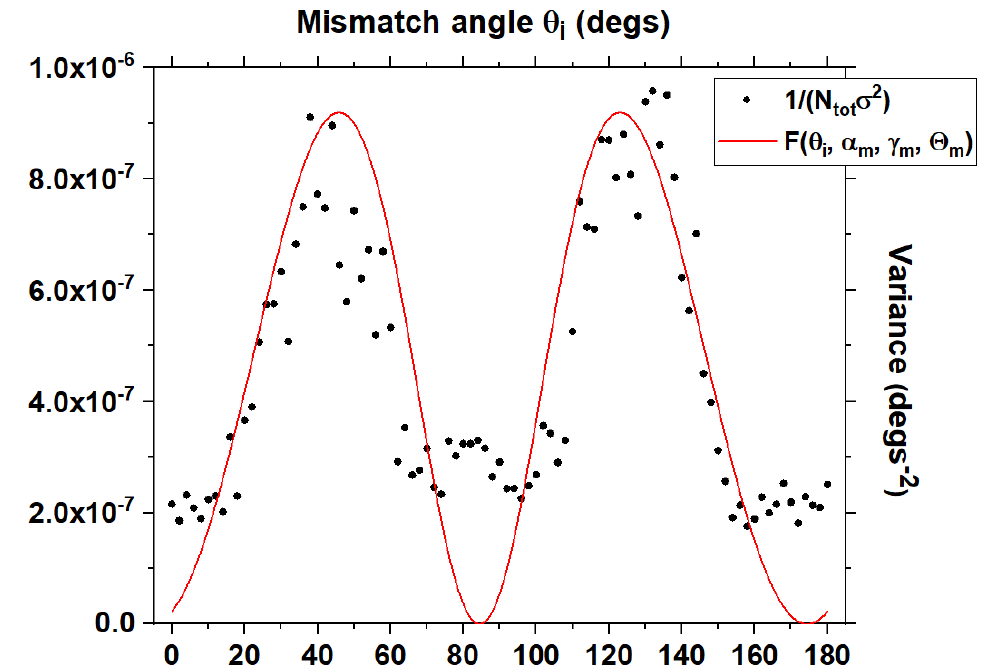
Figure 4. Experimentally retrieved 1/ ( N tot σ 2 ( ˜ θ i )) as a function of θ i , black dots. Theoretical model without free parameters F ( θ i , α m , γ m , Θ m ) (straight red